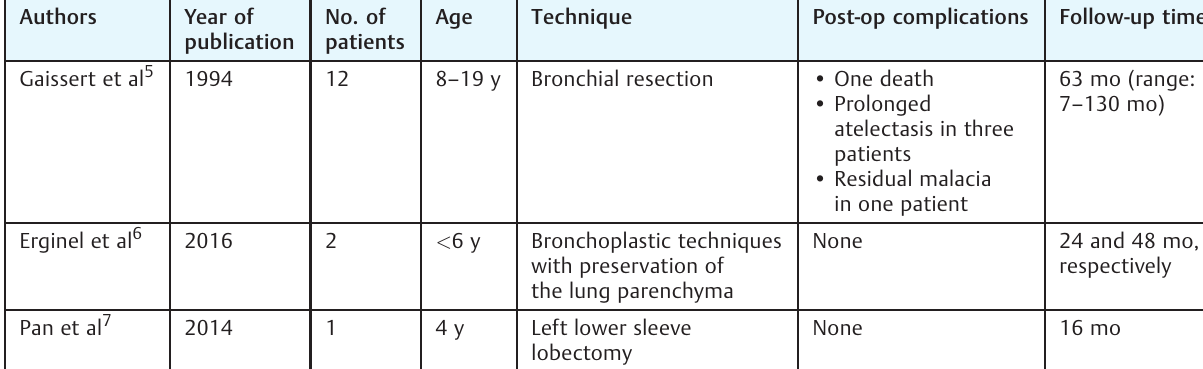
Table 1 Surgical approaches for endobronchial tumors in the literature